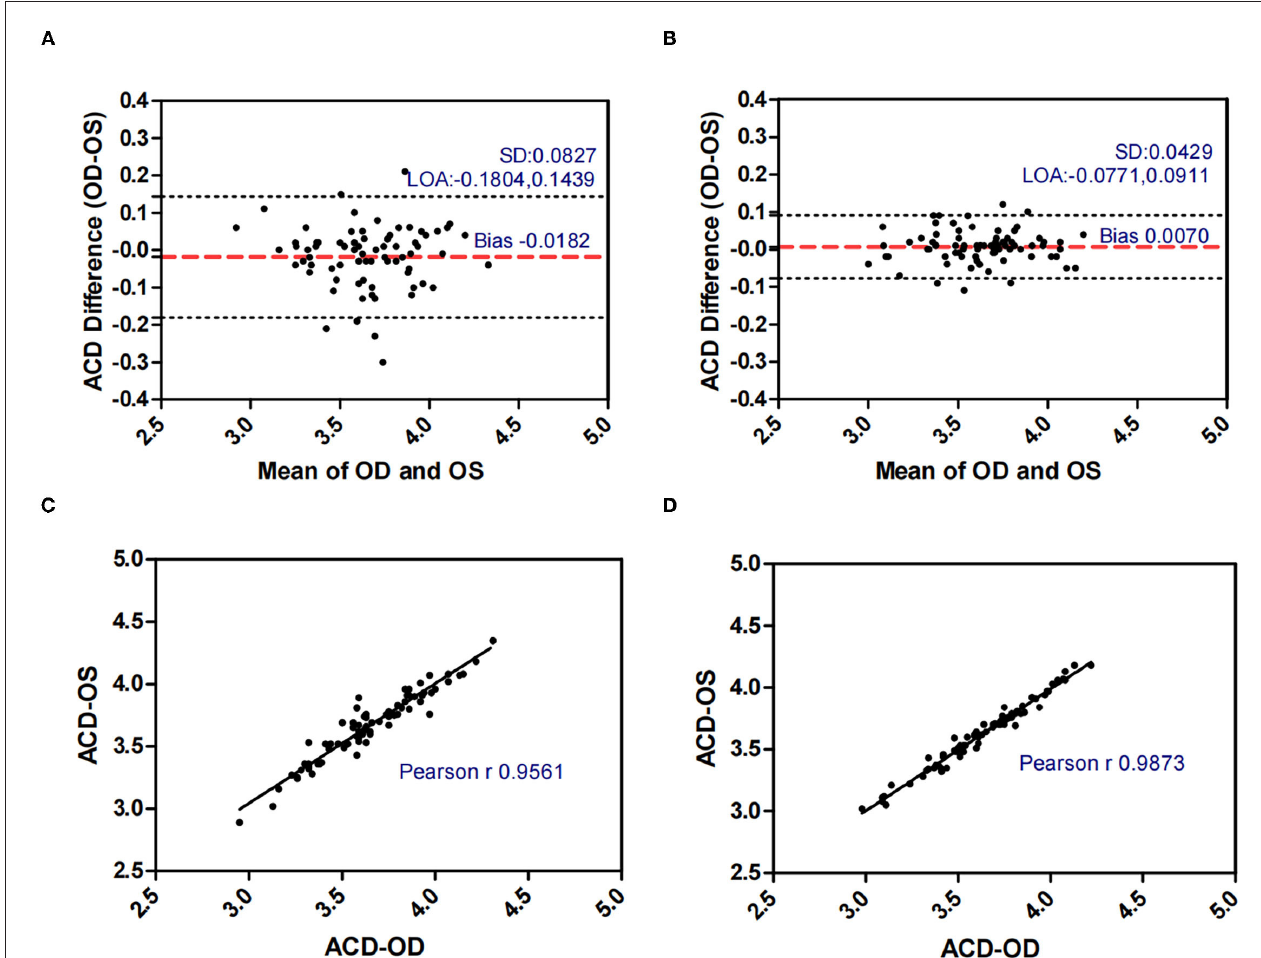
FIGURE 3 | Bland-Altman plots (A,B) and scatter plots (C,D) of ACD in concomitant exotropia (A,C) and normal control participants (B,D) of the left and right eyes. OS, left eye; OD, right eye; ACD, anterior chamber depth; LOA, 95% limits of agreement.